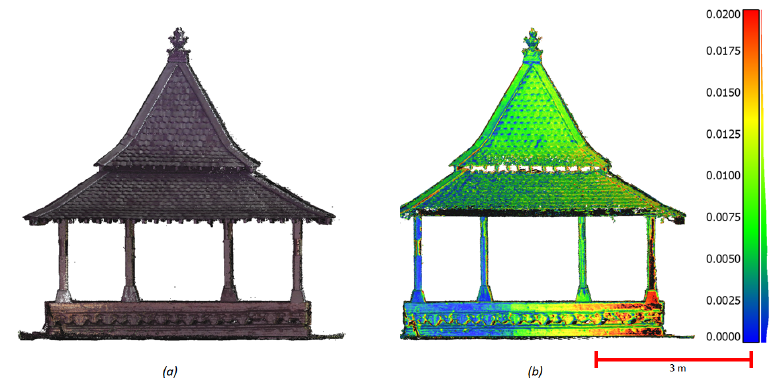
Figure 7. Results for the Central Pavilion in Step 3; ( a ) shows a composite of TLS and close-range photogrammetry point clouds. In ( b ), the absolute distance between points from each point cloud is shown with an average distance of 7 mm and a standard deviation value of 5